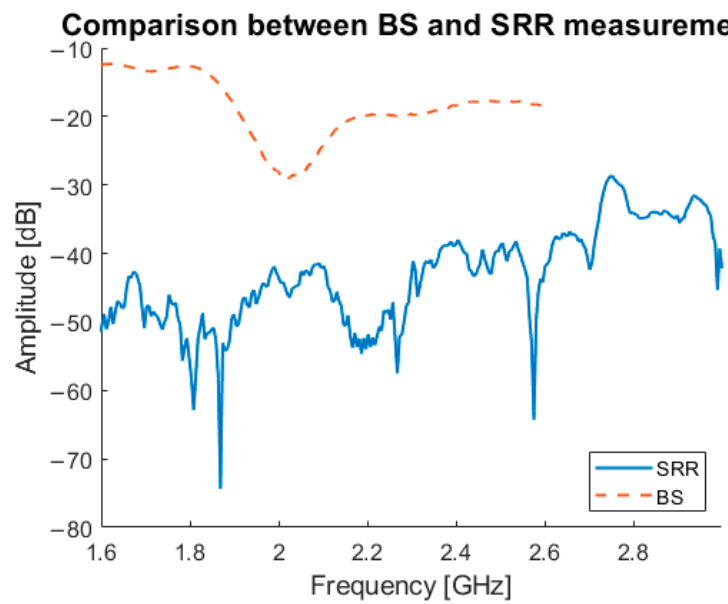
Figure 18. Comparison between the SRR and bandstop sensor.